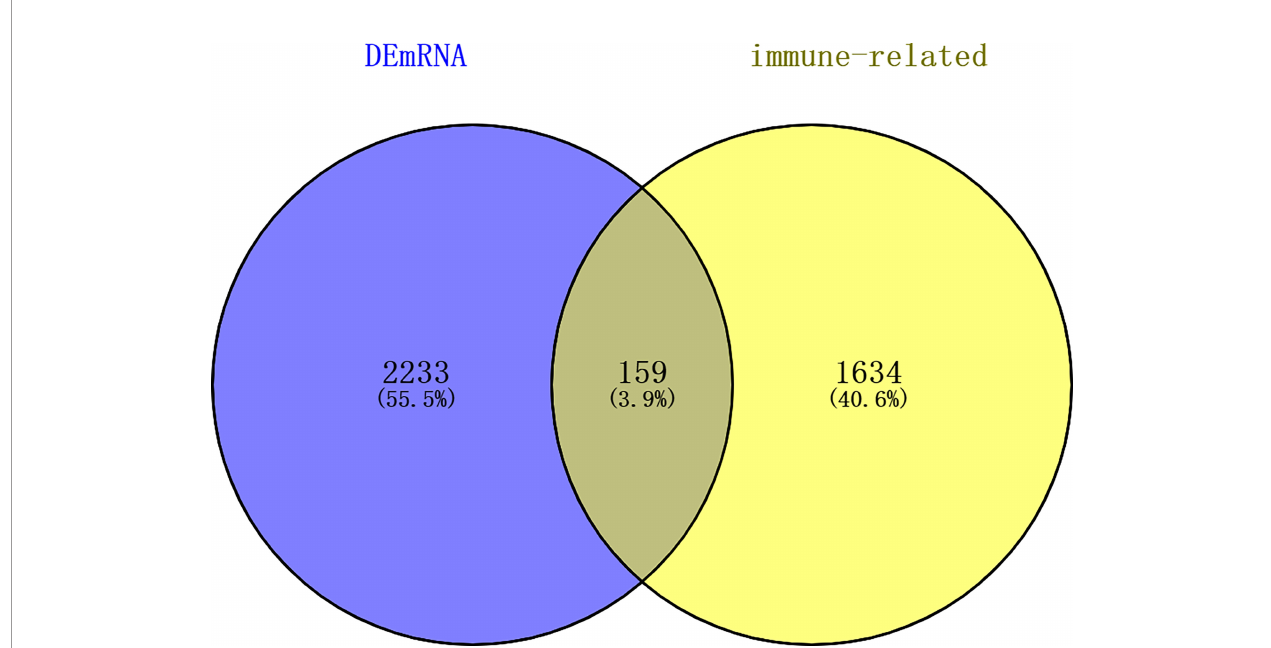
FIGURE 2 | Venn diagram of differentially expressed mRNAs in GC and immune-related mRNAs in the ImmPort database. dEmRNA, differentially expressed mRNA.